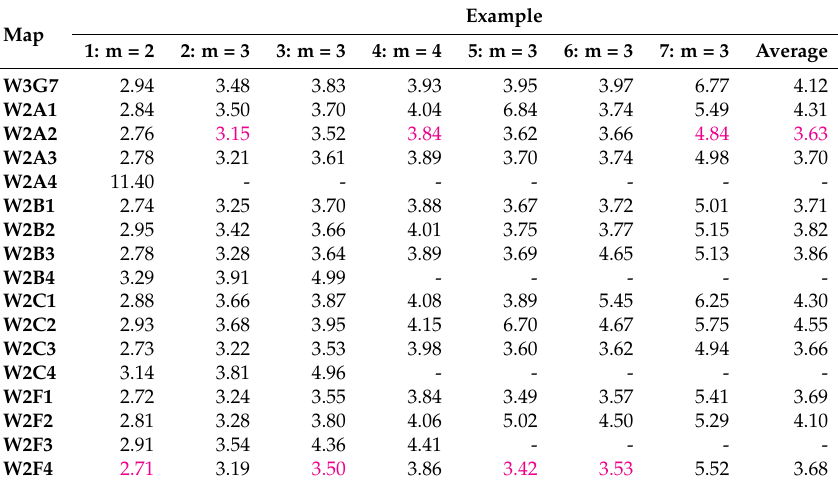
Table 5. Average number of iterations per point for each example (1–7). Map